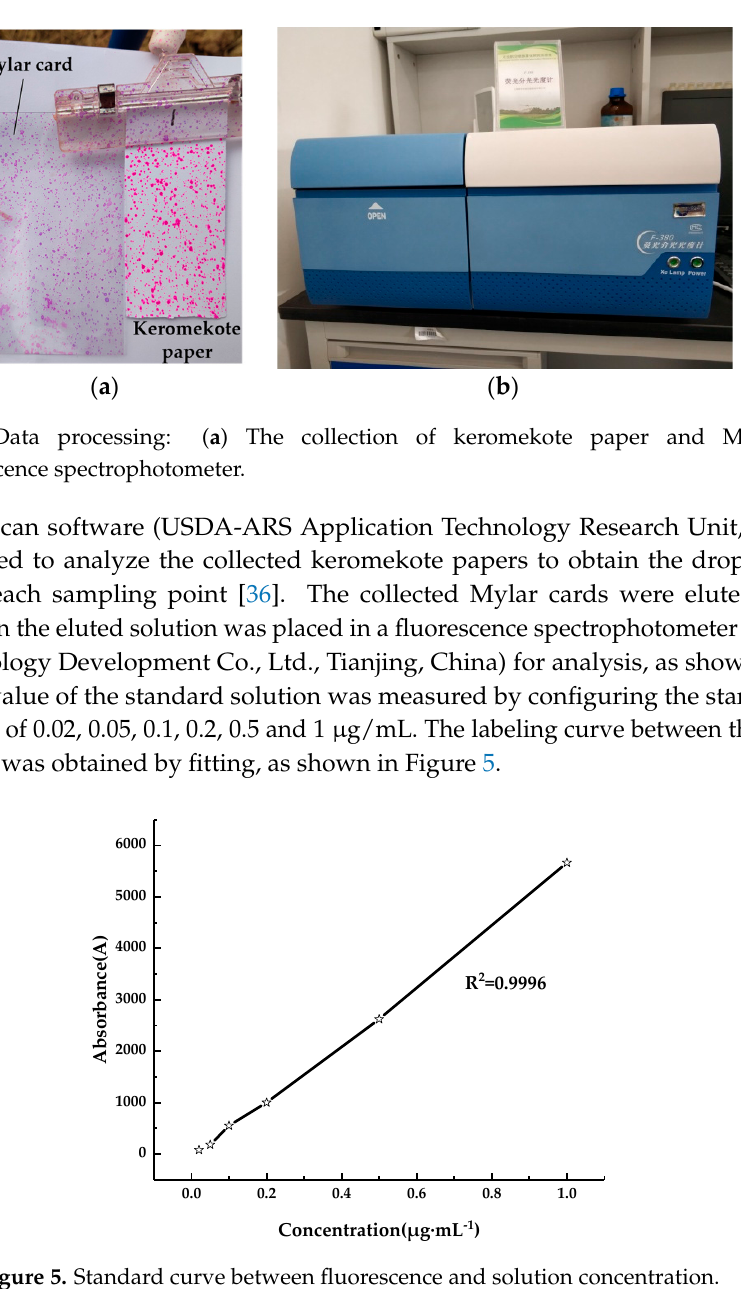
Figure 5. Standard curve between fluorescence and solution concentration